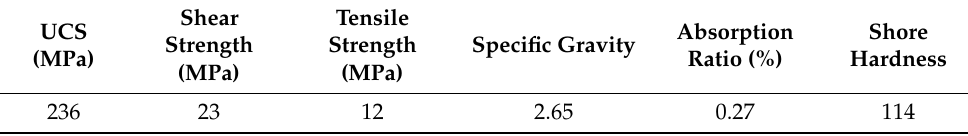
Table 4. Granite specimen